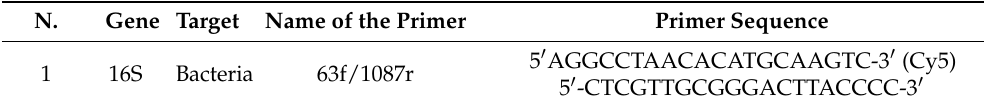
Table 5. Primers for amplification of rumen microorganisms.